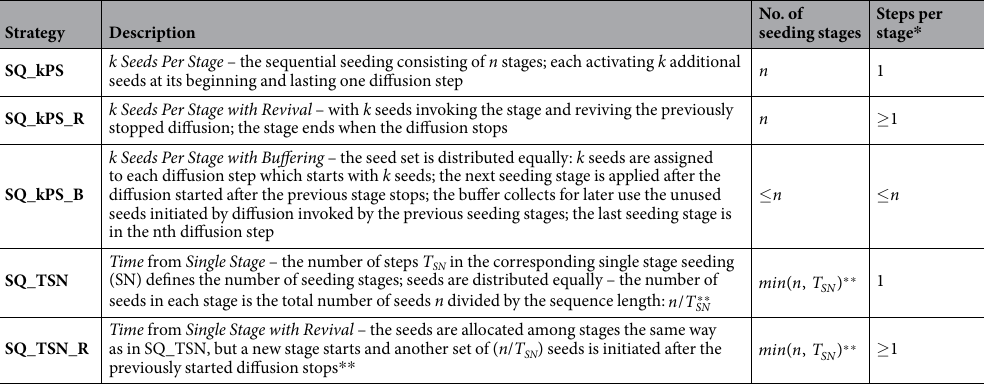
Table 1. New seeding strategies, all based on sequential approach either without or with revival mode; n - denotes the fixed number of seeds, while T SN - the number of diffusion steps in the corresponding single stage approach (SN); * the number of steps in the last seeding stage is not defined and can be greater than 1, since the diffusion proceeds as long as possible. ** If n < T SN , k Seeds Per Stage (SQ_kPS) approach with n stages is used; otherwise seeding consists of T SN